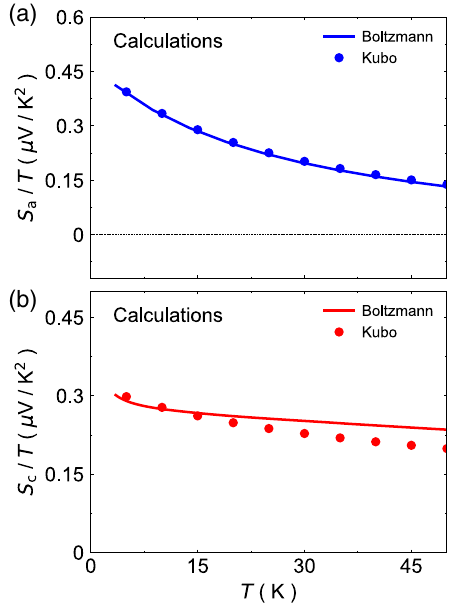
FIG. 11. Comparison between the Kubo and Boltzmann eval- uations of the Seebeck coefficient: (a) in-plane S a ; (b) out-of- plane S c